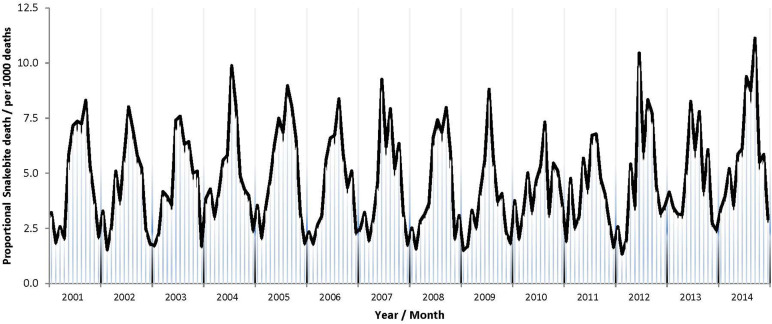
Observed seasonality of snakebite deaths in study data in 2001-2014.Note: Proportional snakebite mortality (monthly snakebite deaths to all causes deaths) reported from the 2001 to 2014 rounds of RGI-MDS.